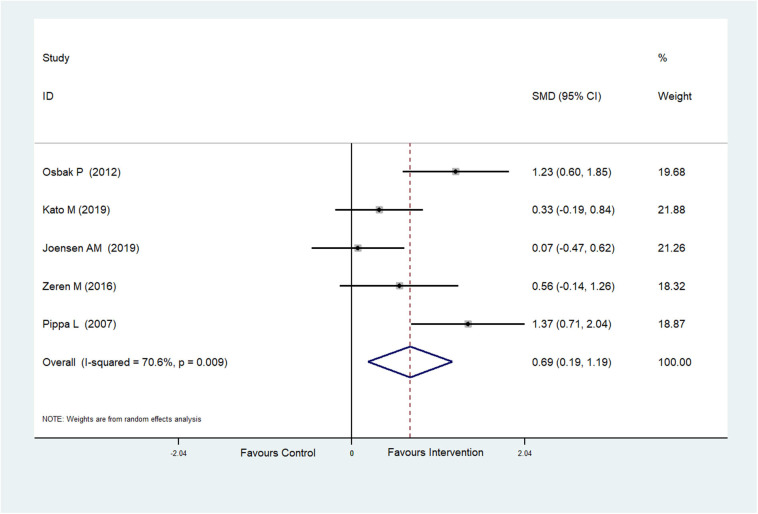
Forest plot shows the ES of physical exercise on 6MWT in AF patients.